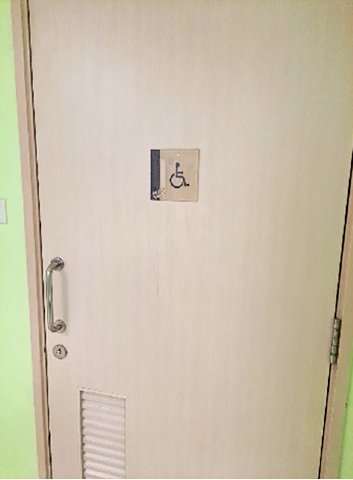
Figure 5. Example of “accessible” door in reality